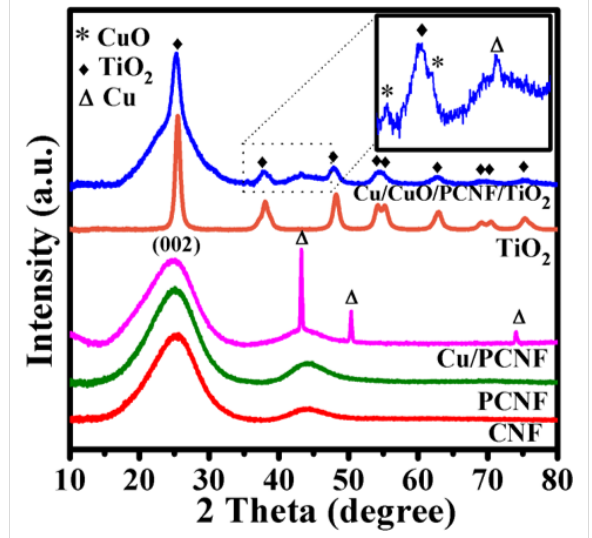
Figure 3: XRD spectra of CNF, PCNF, Cu/PCNF, TiO 2 and Cu/CuO/ PCNF/TiO 2 composites.